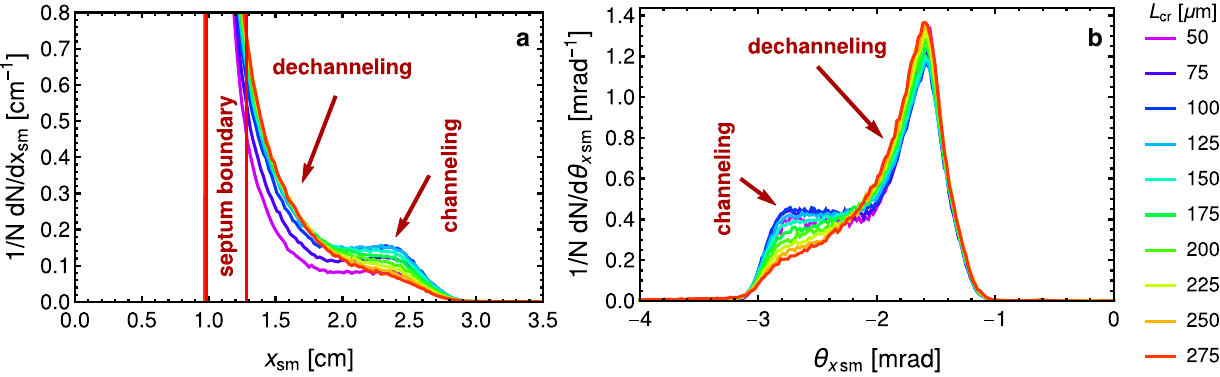
Fig. 15 Multi-turn a transverse coordinate and b angular distributions of the beam deflected by a bent crystal at the position of the septum magnet for different crystal thicknesses and Si crystals bent along the